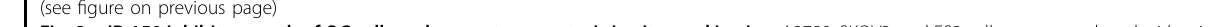
Fig. 2 miR-150 inhibits growth of OC cells and promotes apoptosis in vitro and in vivo. A2780, SKOV3, and ES2 cells were transduced with mir- 150-overexpressing lentivirus (Lv-mir-150) or control lentivirus (Lv-mir-NC). A, B Cell proliferation was determined by colony formation assay ( A ) and EdU incorporation assay ( B ). Scale bar: 100 µm. C Cell cycle was determined by fl ow cytometry. D Cell apoptotic rate was determined by fl ow cytometry of cells with Annexin V-PE/7AA-D double staining. E Levels of Cyclin D1, p27, p21, and p-Rb (Ser795) were detected in Lv-mir-150 cells by western blotting. F ES2 cells stably transfected with Lv-mir-150 (right) or Lv-mir-NC (left) were injected subcutaneously into female BALB/c nude mice ( n = 6), and images of the tumors at autopsy from nude mice were presented (bottom). G Tumor volumes were measured at the indicated time points. H Average weight of xenografted tumors was measured. I Representative photographs of immunohistochemical (IHC) staining of Ki67 in xenografted tumors from Lv-mir-150-ES2 cells or control cells. Magni fi cation: ×400. Scale bar: 50 µm. The data are presented as the mean ± s.d. * P < 0.05, ** P < 0.01, *** P < 0.001, **** P < 0.0001 by Student ’ s t -test or two-way